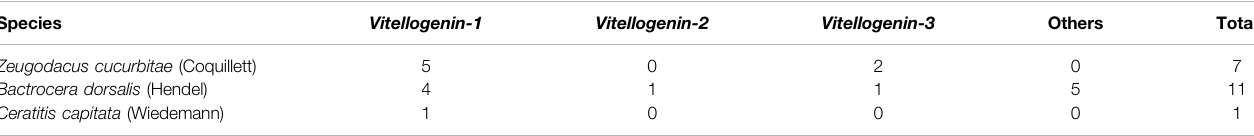
TABLE 9 | Number of Vitellogenin - related genes in speci fi c genes of Zeugodacus cucurbitae (Coquillett), Bactrocera dorsalis (Hendel), and Ceratitis capitata (Wiedemann).